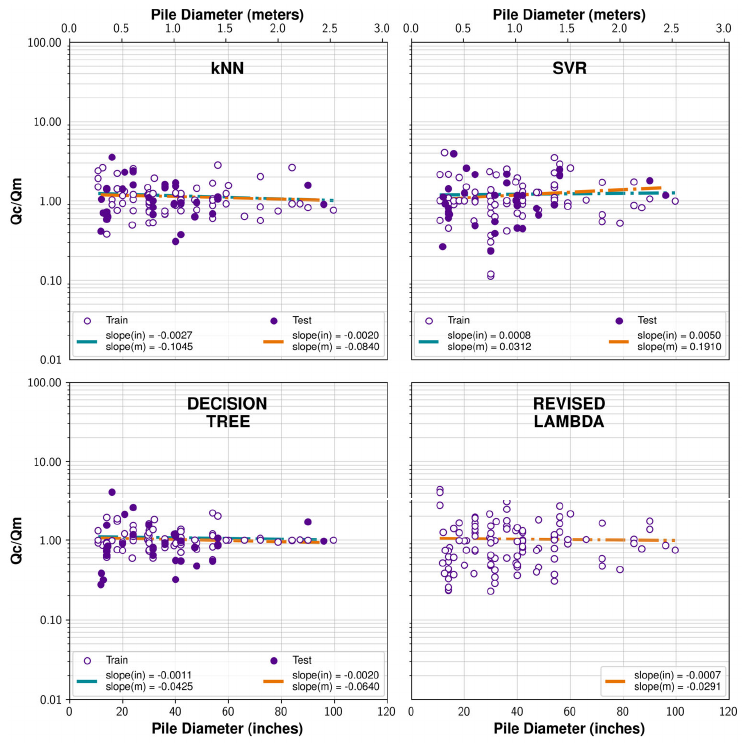
Figure 7. Effectof pilediameter on the performanceof the machinelearning models and theRevised Figure 7. Effect of pile diameter on the performance of the machine learning models and the Revised Lambda method. Lambda method.